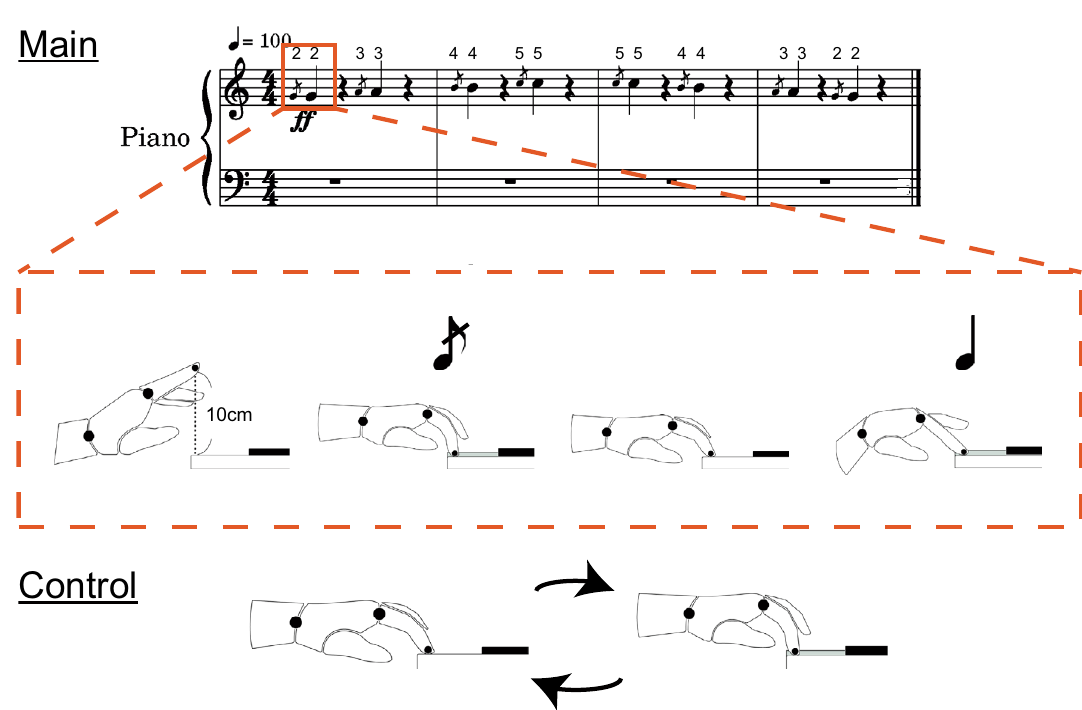
Figure 1. A musical score representing the conditioning task (top panel) and a schematic drawing of the keystroke movements corresponding to the repetitive keystrokes used by the main group with the plyometric activity (middle panel) and control group who underwent the same number of keystrokes as the main group (bottom panel). The number on the score represents the fingering (2, 3, 4, and 5 corresponds the index, middle, ring, and little finger,